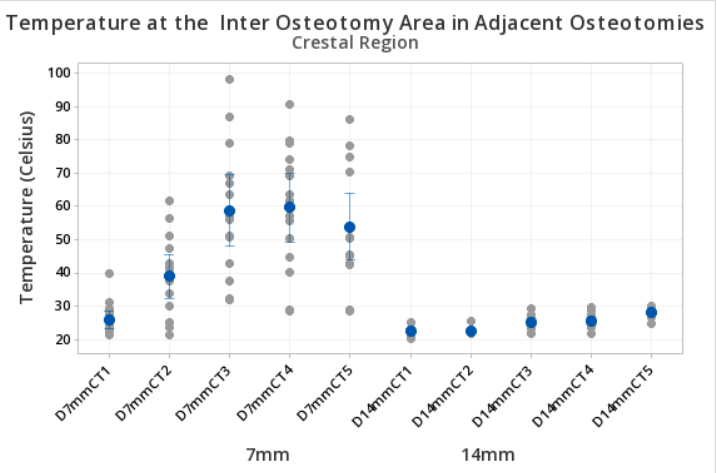
Figure 4. Temperature in the inter-osteotomy area. Measurements at the coronal level. The y axis shows the temperature reached during the preparation of the osteotomies. The x axis indicates the different test groups at 7 mm and 14 mm inter-osteotomy separations at the coronal level. Ascending temperatures were observed in both groups and were influenced by the time and separation between osteotomies. D = distance, C = crestal, T = time (T1 = 20 s, T2 = 40 s, T3 = 60 s, T4 = 80 s, T5 = 100 s). The blue dots represent the central mean value. The grey dots represent the distribution of upper and lower temperatures (sometimes overlapping). The blue lines if present, represent standard deviations.